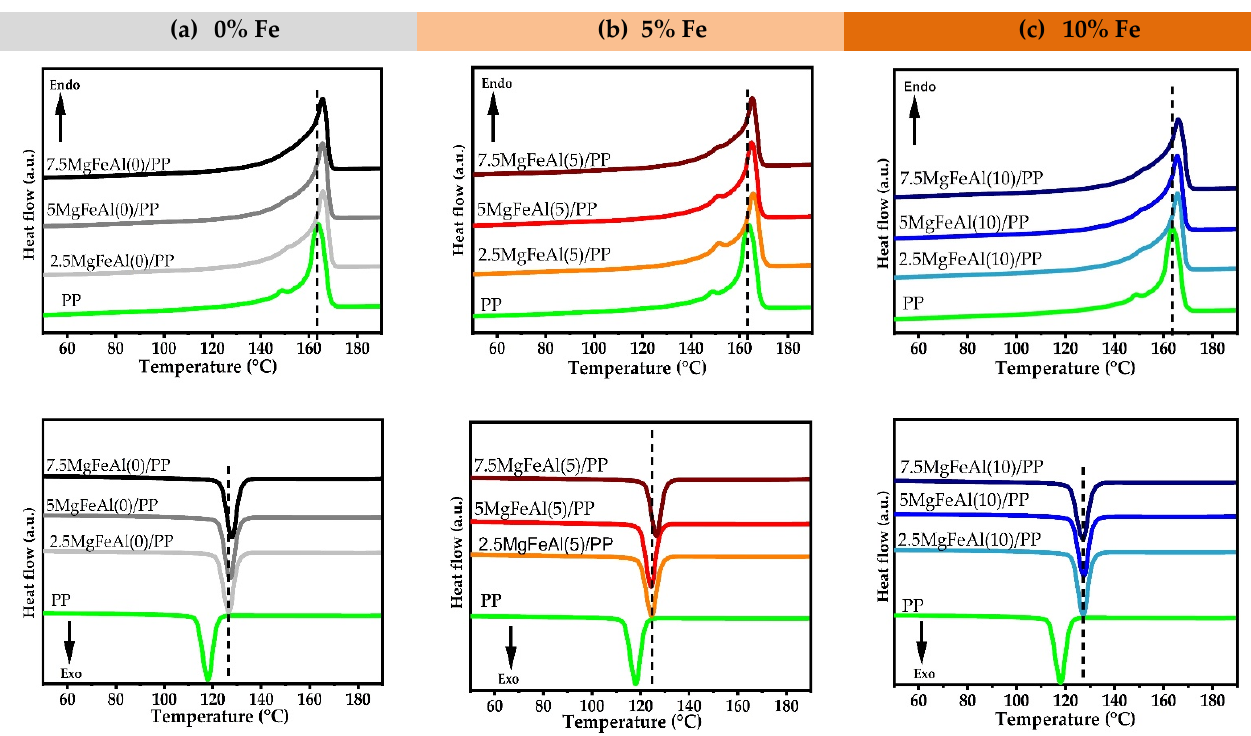
Figure 5. DSC thermograms of different LDH/PP nanocomposites: ( a ) 0, ( b ) 5 and ( c ) 10% Fe.